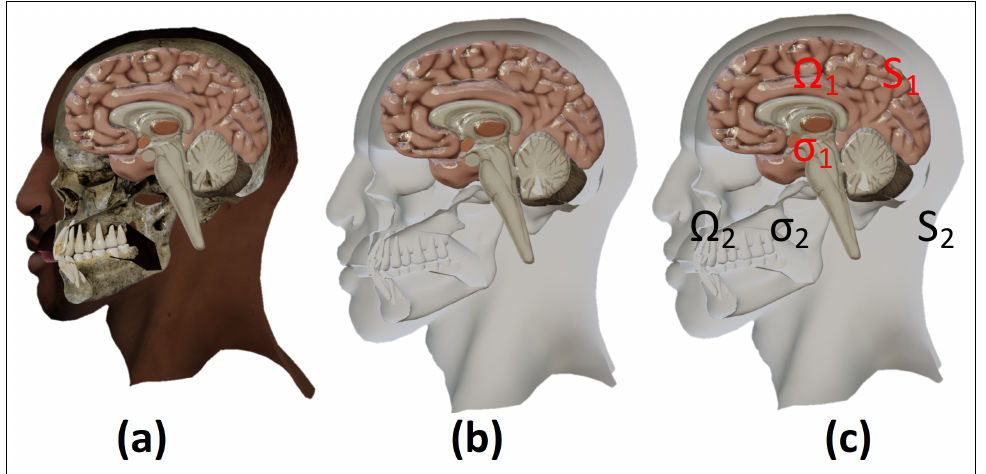
Figure 2. ( a ) 3D model in Figure 1e; ( b ) 3D model showing the scalp and skull as a single region (region 2) in a light-tone color (similar to white); ( c ) two different regions 1 and 2, with different conductivities σ 1 and σ 2 , and outer regions S 1 and S 2 , respectively, for the regions Ω 1 and Ω 2